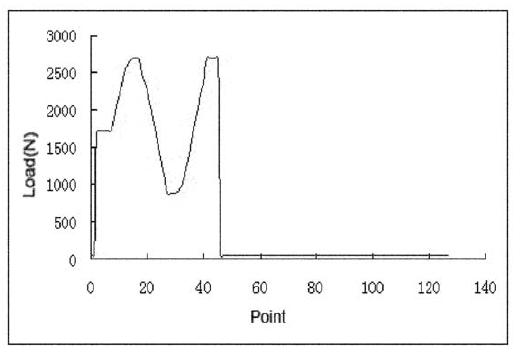
Figure 3. The loads used in hip simulator